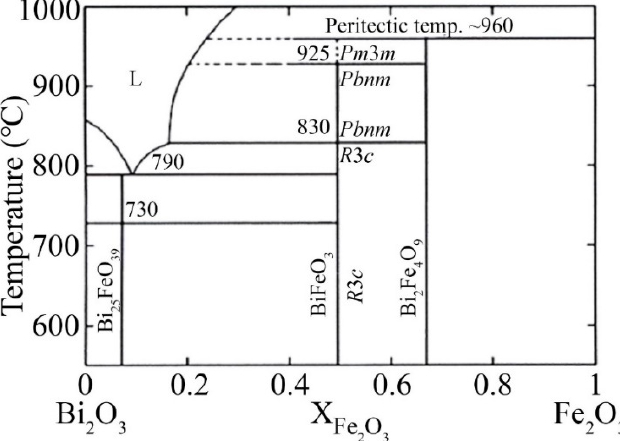
Figure 3. Phase diagram of the Bi 2 O 3 -Fe 2 O 3 binary system.